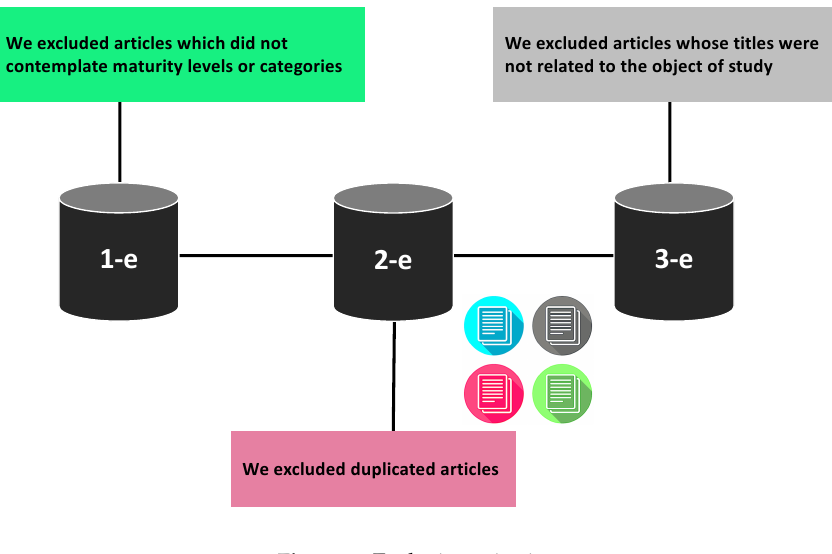
Figure 3. Exclusion